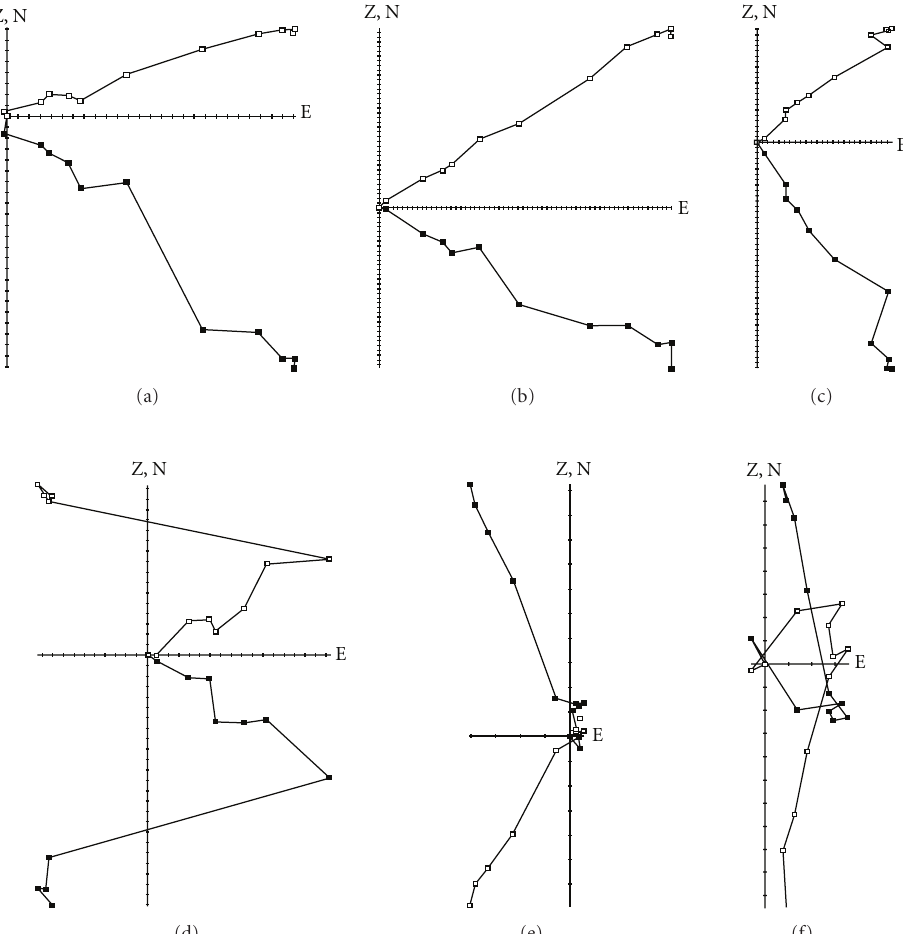
Figure 3: Orthogonal demagnetization (“Zijderveld”) plots of representative samples after dip correction (stratigraphic coordinates). Solid squares indicate declination (horizontal projection); open squares indicate inclination (vertical projection). First step is NRM, followed by AF steps of 2.5, 5, and 10mT, then thermal steps from 200 ◦ to 630 ◦ C in 50 ◦ C increments. Each division equals 10 − 3 A/m. See text for discussion of individual sample